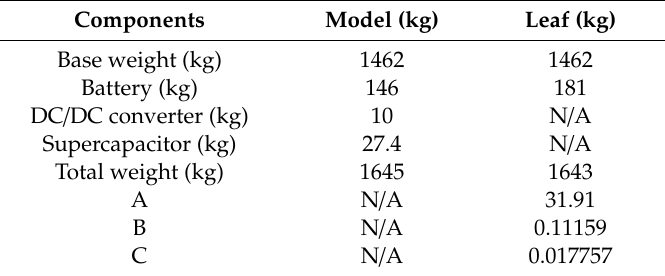
Table 2. Component